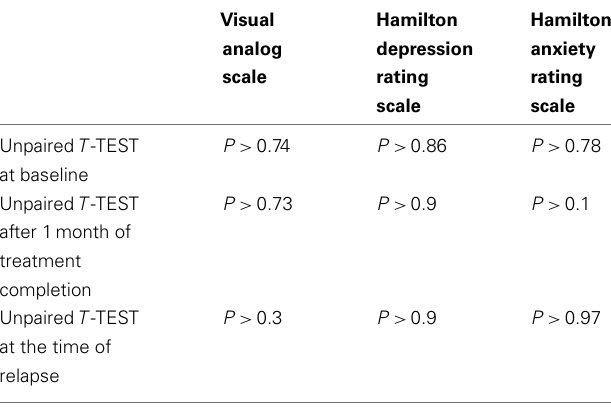
HDRS, Hamilton depression rating scale; HARS, Hamilton anxiety rating scale; VAS, visual analog